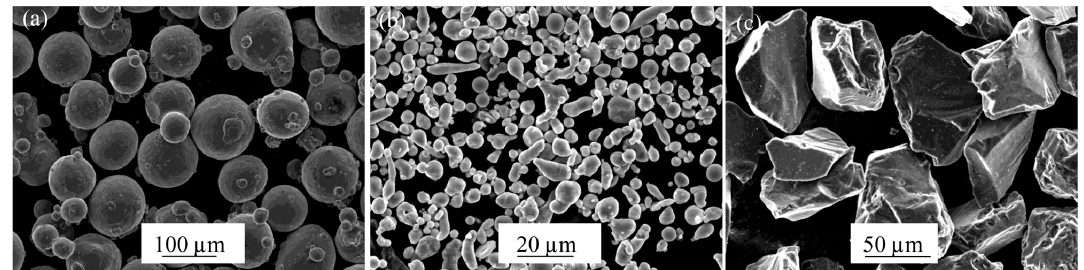
Figure 1. SEM images of the raw powders; ( a ) spherical titanium matrix powder morphology; ( b ) blended powders of fine titanium and aluminium particles; ( c ) irregular and angular B 4 C particles.